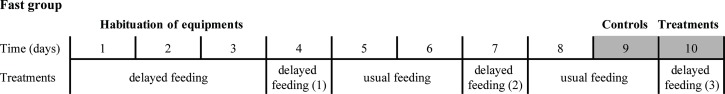
A schematic diagram of the delayed-feeding schedule for the Fast group, which were dogs that consumed their food completely and did not chew every mouthful more than once.Habituation to the delayed automatic feeding equipment occurred over three consecutive days prior to examining the effects of delayed feeding. Blood samples for the comparison between the controlled and delayed-feeding conditions were taken from different dogs. Controls (n = 10) were Fast dogs with delayed feeding, and their blood samples were collected before (Pre) and after (Post) usual feeding on the 9th day of the delayed-feeding experiment. On the 10th day of the experiment, pre- and post- delayed-feeding blood samples were collected (Treatments, n = 9).